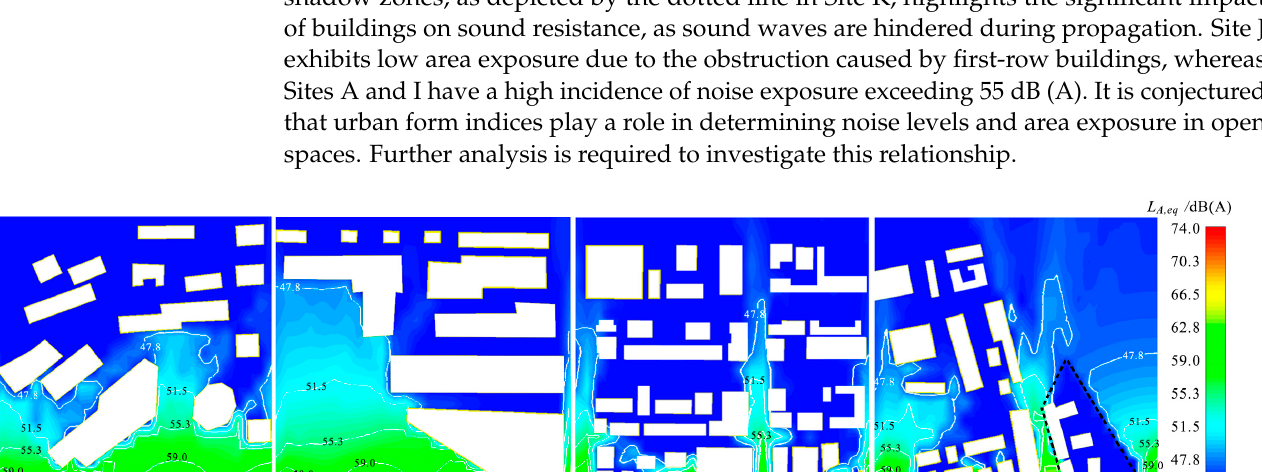
Figure 7. Noise exposure maps in open areas 1.2 m above the ground with four air filters in Sites A, I, J, and K (the dotted line in Site K represents the shadow zone created by the resistance effect of